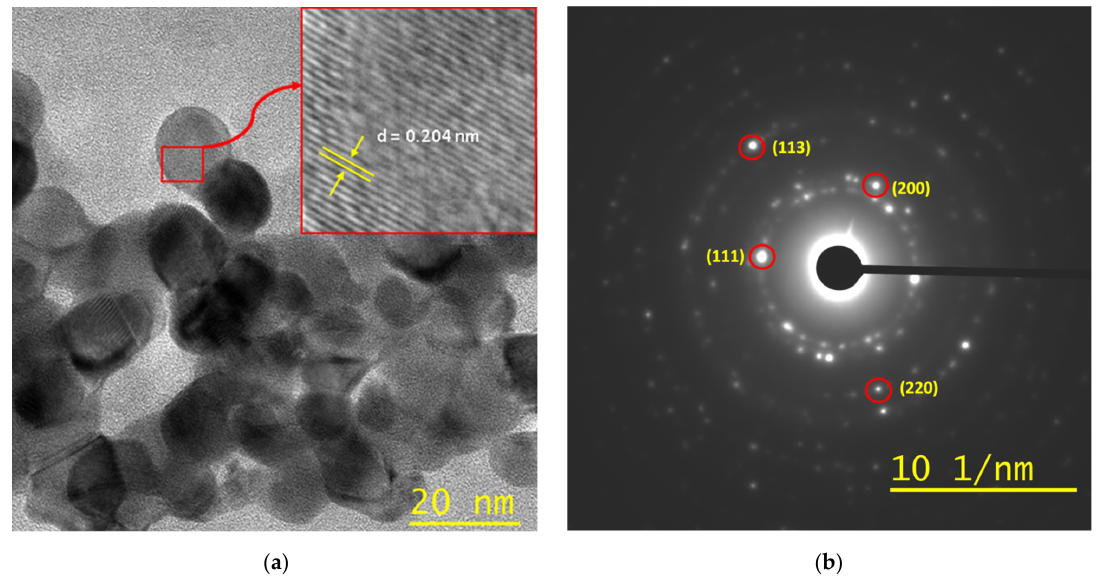
Figure 4. ( a ) HRTEM micrographs of nanoparticles formed in the irradiated film. ( b ) The SAED patterns for the cluster of nanoparticles on ( a ). Red circles show reflections of the corresponding planes of metallic Au Heating of these samples at a temperature lower than 110 °C without the previous irradiation does not provide any nanoparticles. This is confirmed by the image shown in Figure 5. Here, the irradiated regions demonstrate red color after heating, whereas the non-irradiated parts of the same samples remain intact.